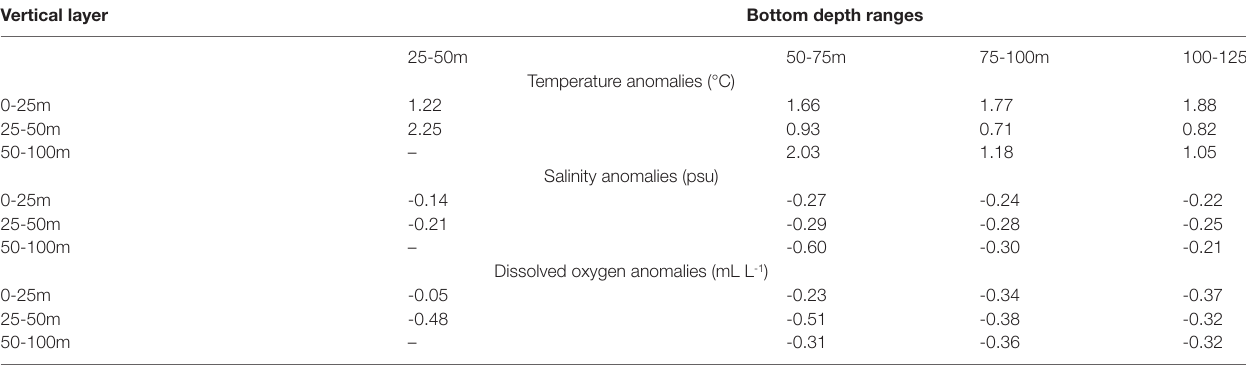
TABLE 1 | Water temperature, salinity, and dissolved oxygen anomalies from glider observations in the deeper and shallower parts of the Bothnian Sea. Vertical